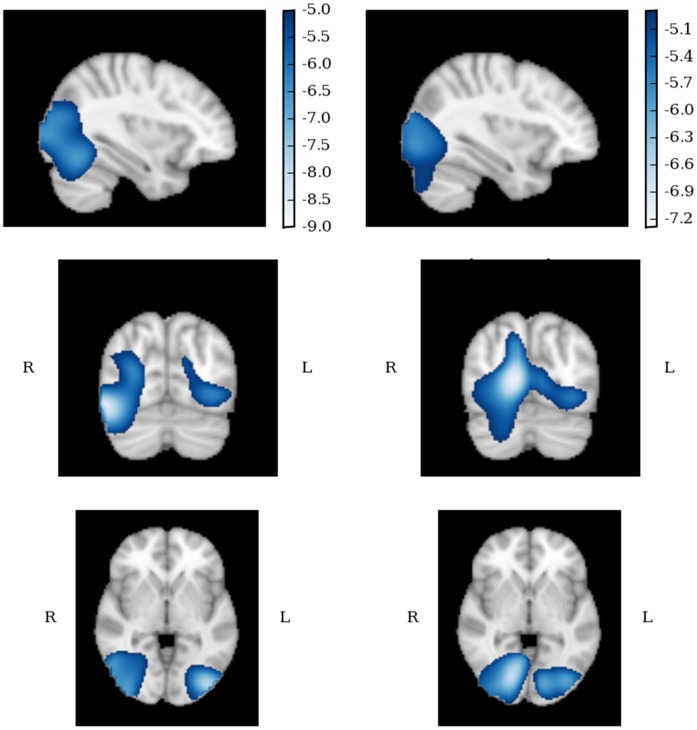
The lower band response (3–30 Hz), in TD (left) and ASD (right) participants.Red  =  maxima, blue  =  minima p<.05 for all highlighted voxels. Slice shown MNI: 32, −72, −2.